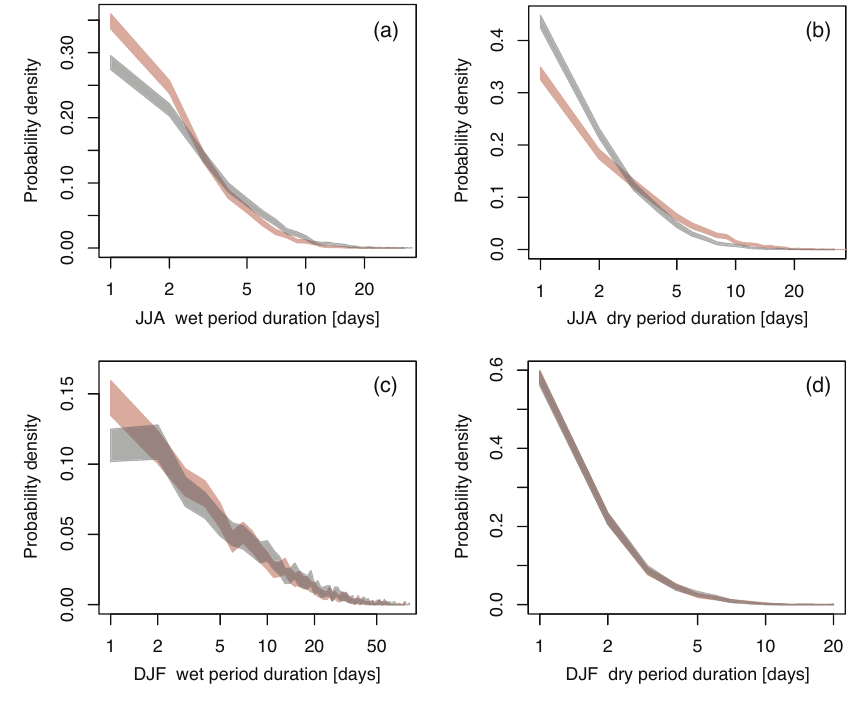
Fig. 4. Probability density functions for wet (left) and dry (right) period durations in JJA (top row) and DJF (lower row) for the North Rhine region. Shaded regions show 95% confidence intervals from bootstrapping for the 1961/1962–1990/1991 (control) time slice (gray) and the 2070/2071–2099/2100 (future) time slice (color).